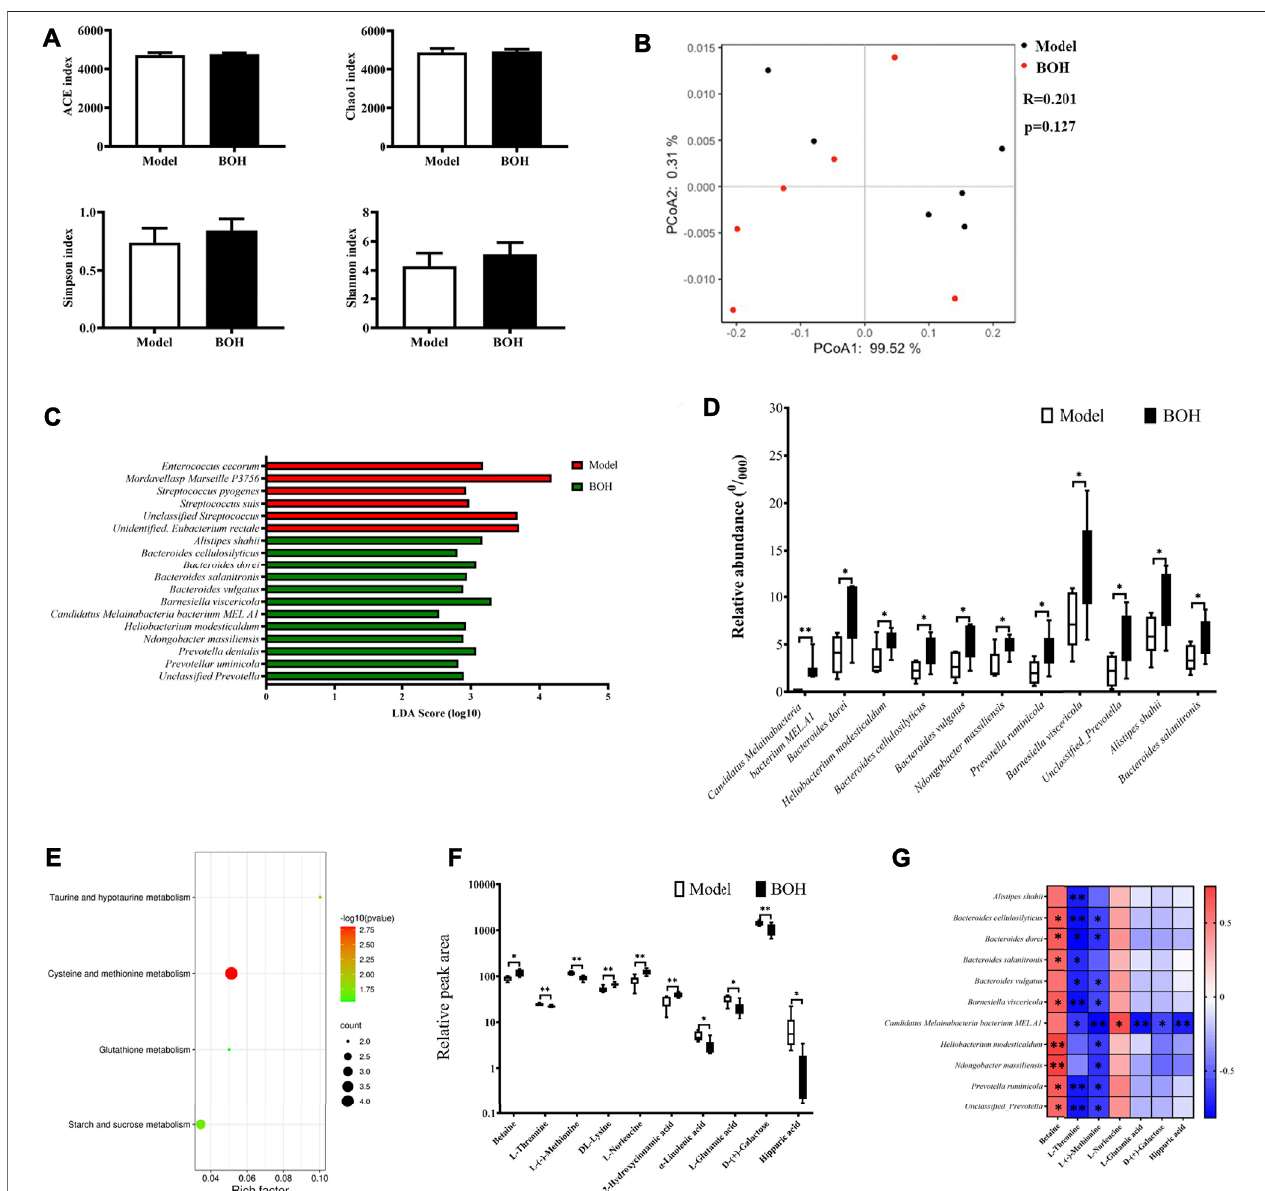
FIGURE 5 | BO alters the taxonomy and function of gut microbiota and regulated amino acid pro fi le in serum. (A) Indices of a -diversity analysis, including ACE, Chao1,ShannonandSimpson. (B) ß -diversityanalysis,includingUniFrac distance-based principalcoordinatesanalysis (PCoA) and analysisofsimilarities (ANOSIM). (C,D) LEfSe analysis and the differential species. (E) Enriched function pathway based on differential genes. (F,G) Differential metabolites in serum and their correlations with the differential species. n (cid:2) 6. * p < 0.05 and ** p < 0.01 vs. model group.